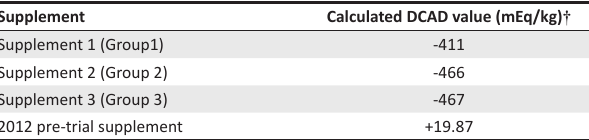
TABLE 5: Calculated dietary cation anion difference values of respective supplements.